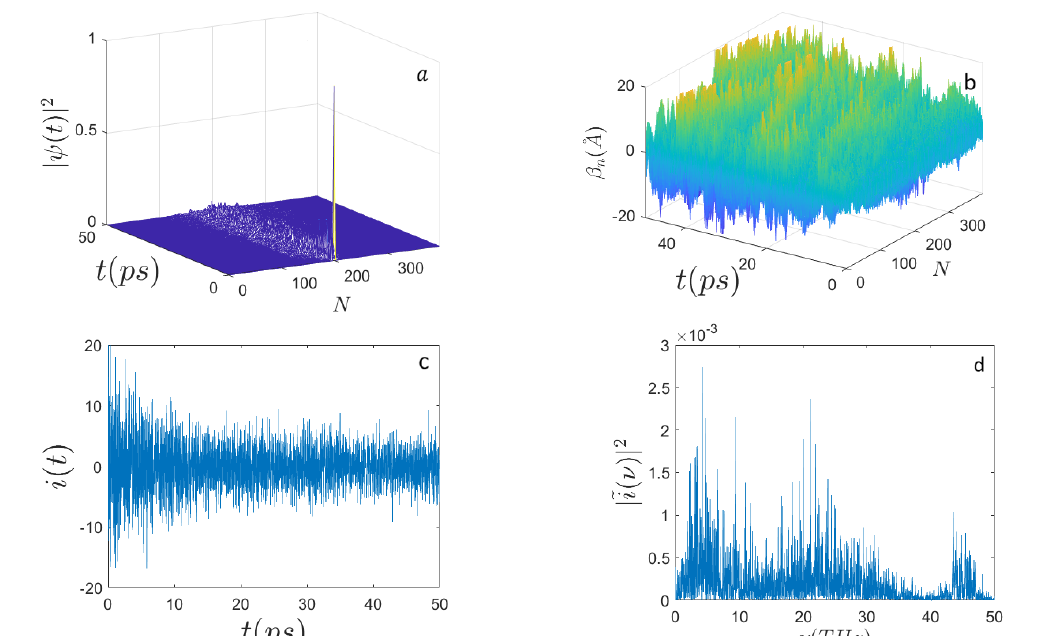
Figure 4. Time evolution of ( a ) the electron probability amplitude | Ψ ( t ) | 2 ; ( b ) the average displace- ments β n ( ˚ A ) ; ( c ) the electron current i ( t ) (expressed in µ biot); ( d ) the frequency spectrum | ˜ i ( ν ) | 2 along the sequence of N = 398 nucleotides with the initial condition E 0 = 0.46 eV ( E (cid:48) = 70). The initial electron excitation peaks around the site n 0 = N /2. The other parameters are the same as those in Figure